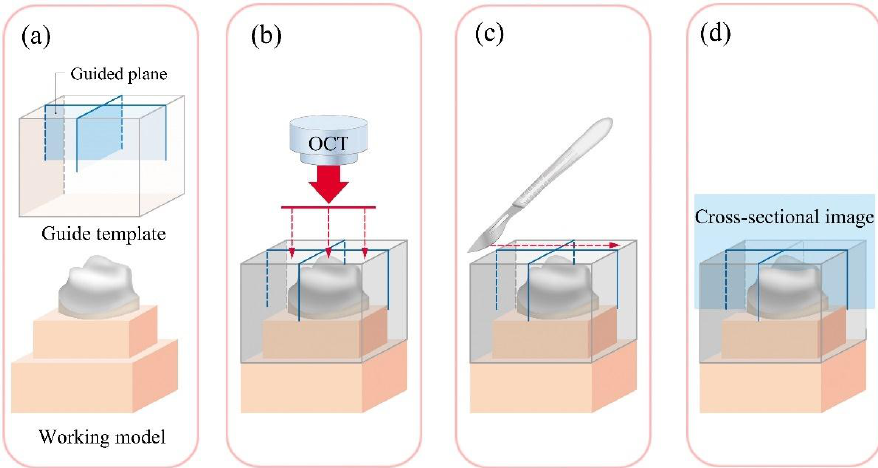
Figure 1. Acquisition and application of the same cross-sectional image. ( a ) Designed so that a guided plane would be formed according to the guide template and connected to the study model; ( b ) The optical beam in optical coherence tomography (OCT) was guided according to the template; ( c ) Cutting of the silicone replica in the silicone replica technique was guided according to the template; ( d ) All assessment methods were analyzed in an identical cross-sectional image according to the guide template.